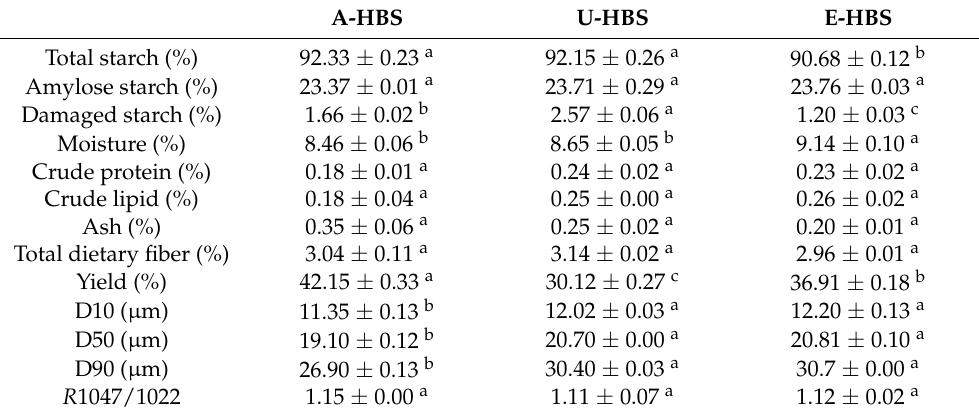
A-HBS: HBS extracted by alkali method; U-HBS: HBS extracted by ultrasonic method; E-HBS: HBS extracted by enzymatic method. Mean ± SD is calculated from triplicate measurements. Different lowercase letters represent significant difference ( p <